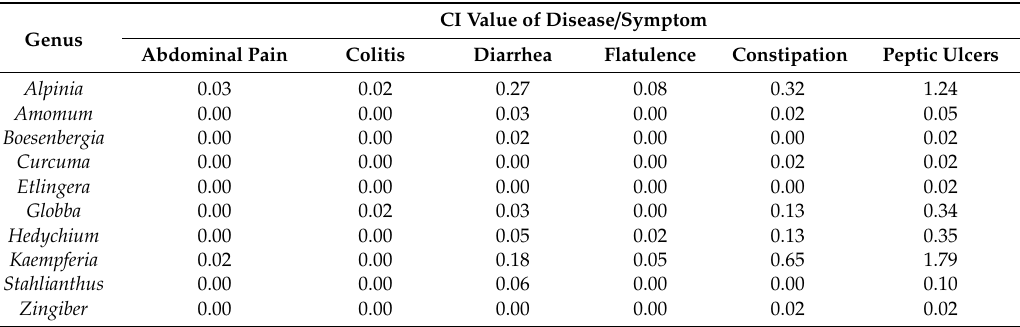
Table 3. Cultural Importance Index (CI) for ginger genera used in the treatment of six health conditions under the category of digestive system disorders (abdominal pain, colitis, diarrhea, flatulence, constipation and peptic ulcers) extracted from 62 references covering 104 villages in